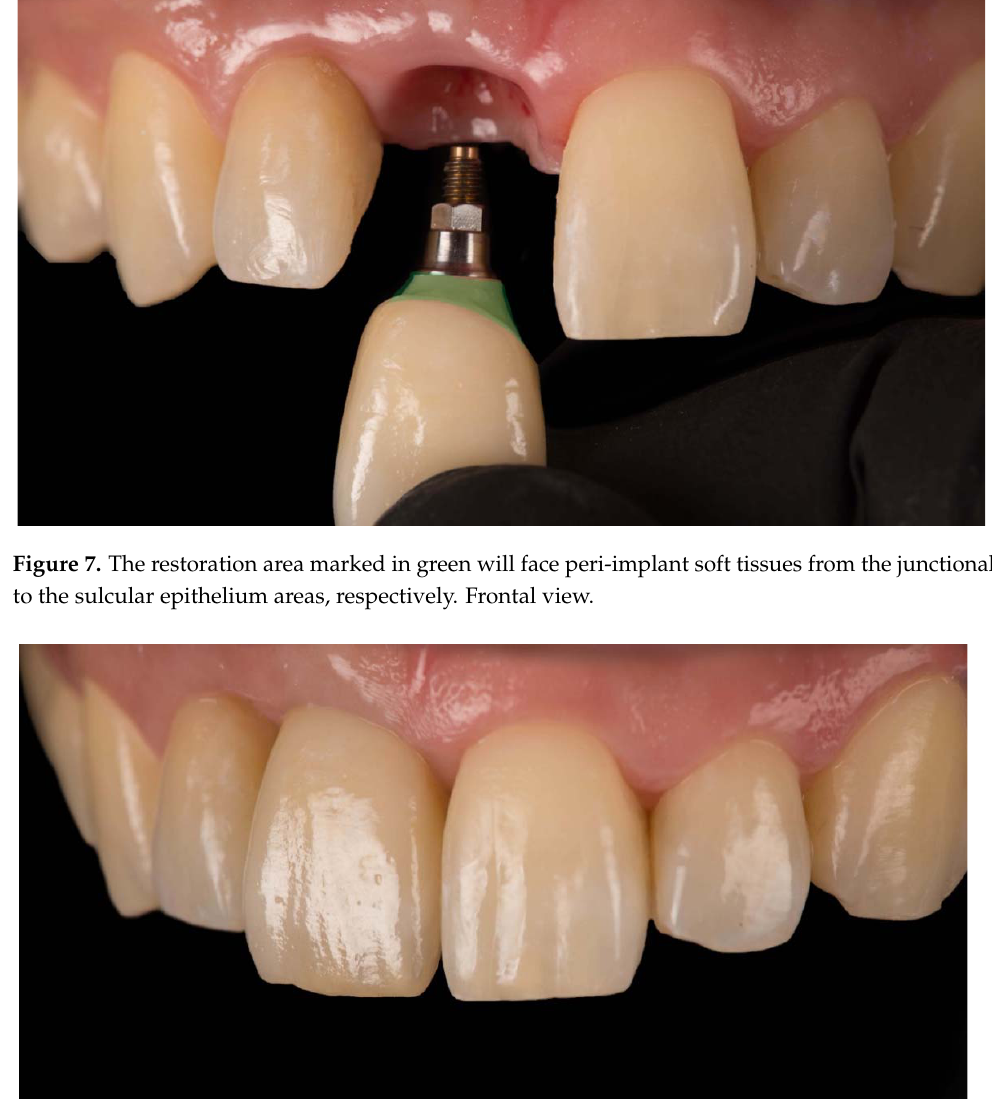
Figure 6. Stable peri ‐ implant soft tissues before screwing the implant ‐ supported restoration. Frontal view.